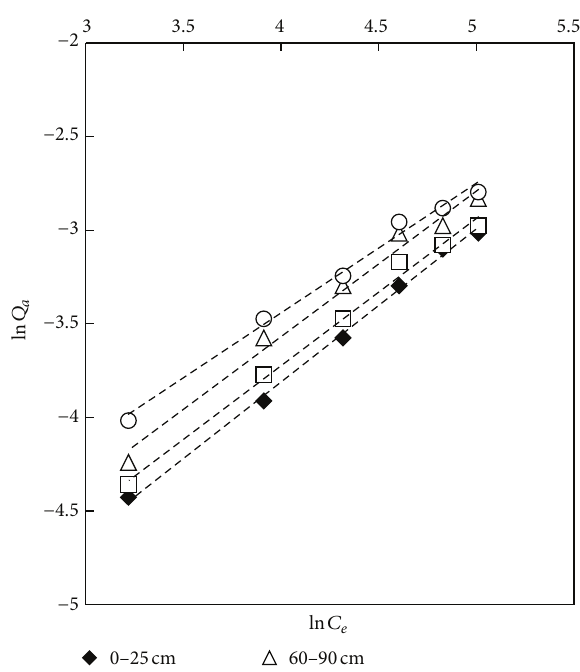
Figure 4: Langmuir isotherms for NO 3− sorption by soil profile at (25, 50, 75, 100, 125, and 150mg NO 3− L −1 , 22 ∘ C, 24 h, and soil mass = 5g).